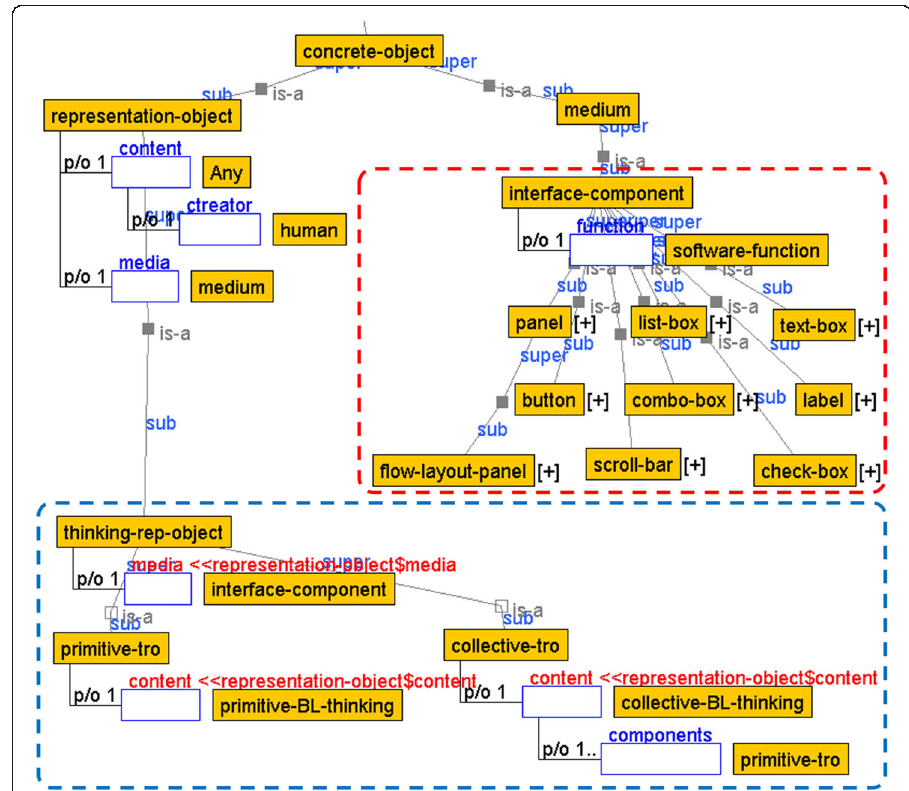
Fig. 3 Concepts of thinking representation